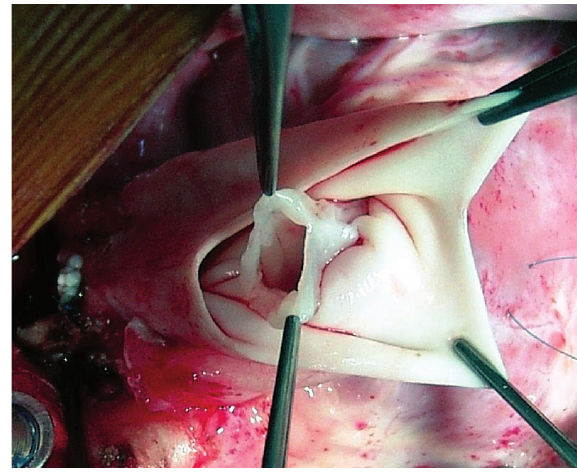
Fig. 3 – Artéria pulmonar aberta longitudinalmente, expondo a valva pulmonar bivalvulada e